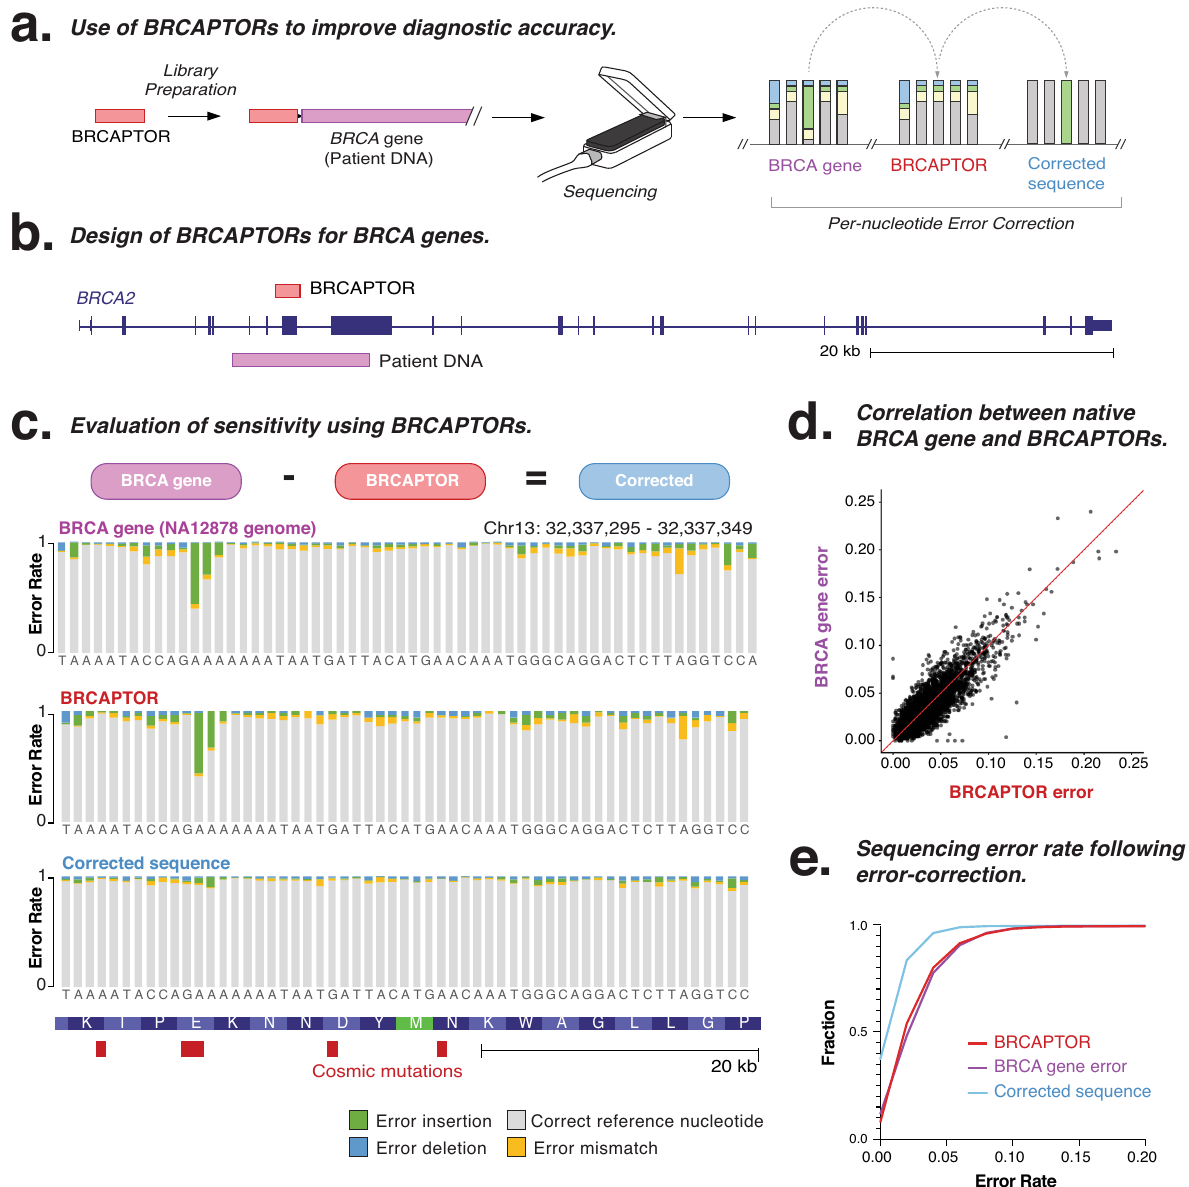
Fig.5|Improvingthediagnosisofmutationsin BRCA genesusingBRCAPTORs. a Schematicdiagram illustrates the useofCAPTORsthat encodereferencecontrol sequences for clinically important genes to perform per-nucleotide error correc- tion of accompanying human patient DNA samples. b Genome browser shows the designofBRCAPTORsrepresentingaclinicallyimportantsequencefromthe BRCA2 gene. c Per-nucleotide error pro fi le shows the sequencing error rate for